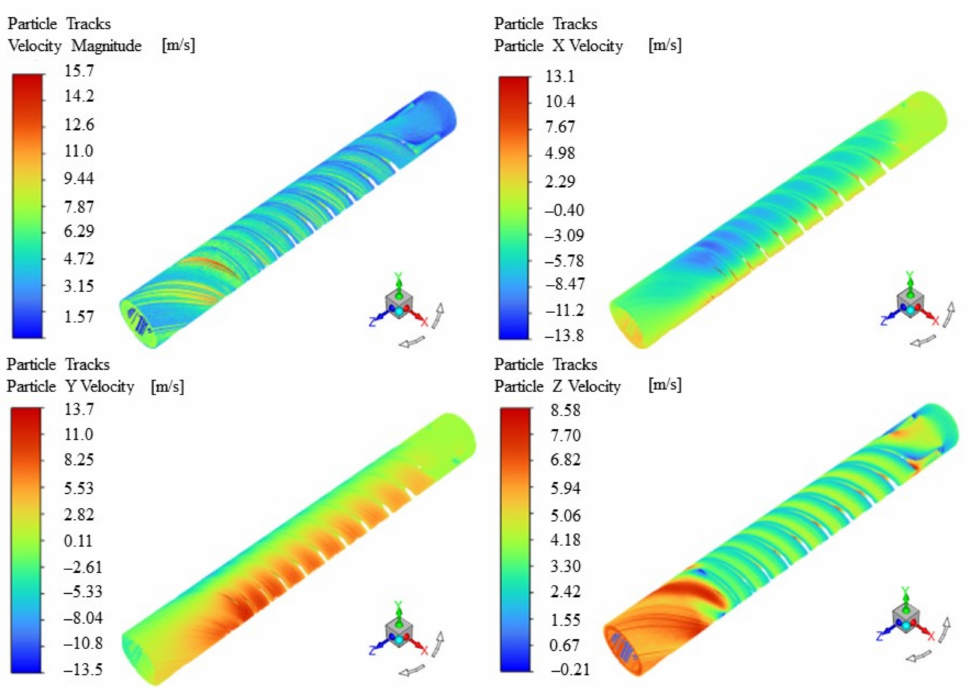
Figure 9. Velocity distribution of sand particles in variable pitch cyclone separator after optimization.